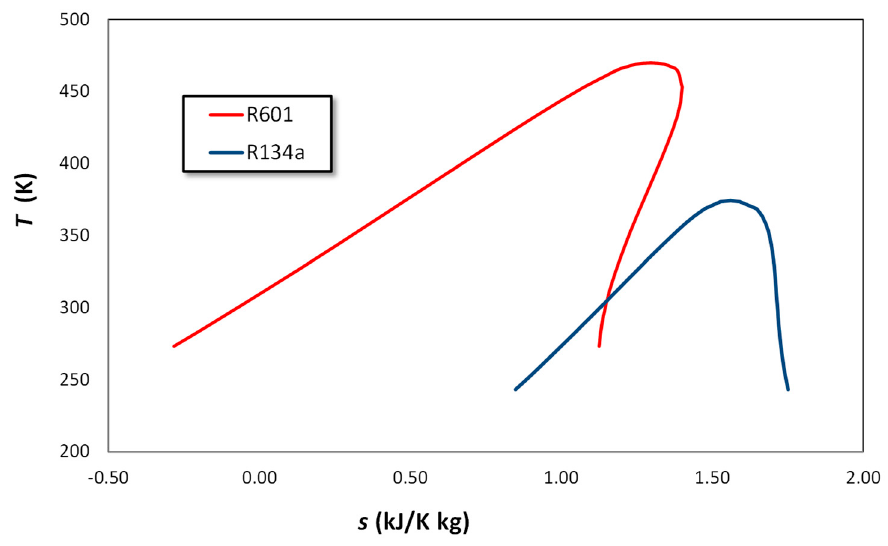
Figure 6. Saturation curves for n-pentane and R134a.